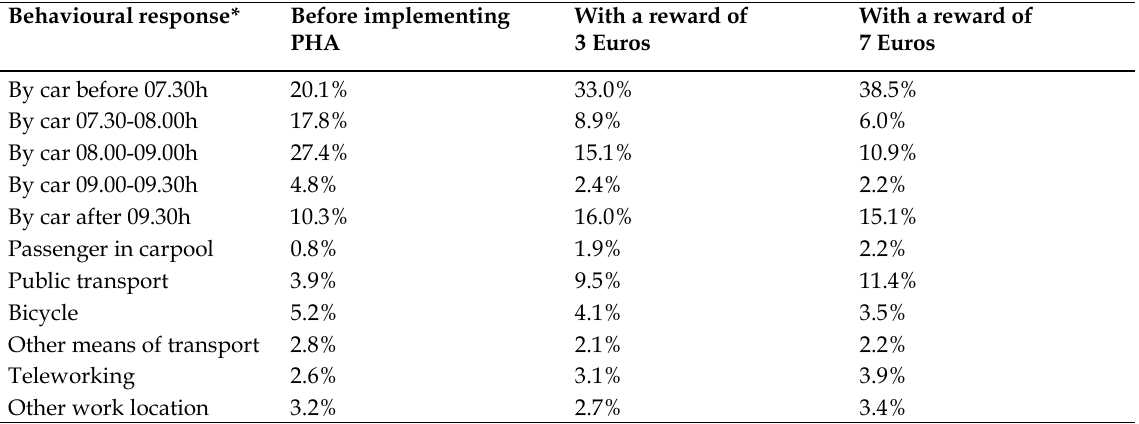
Table 1. Alternatives chosen by PHA participants, adapted from Knockaert et al. (2007) Behavioural response* Before implementing With a reward of With a reward of PHA 3 Euros 7 Euros By car before 07.30h 20.1% 33.0% 38.5% By car 07.30-08.00h By car 08.00-09.00h